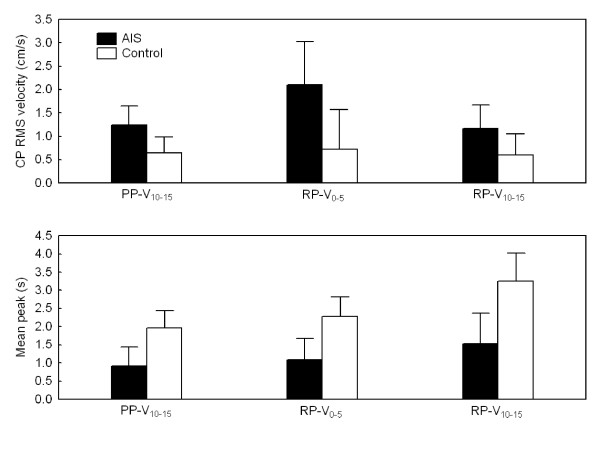
Balance control performance during reintegration of ankle proprioception when vision is available. Upper panel illustrates the interaction Group by Epoch for the CP RMS velocity for the last 5 s epoch of sensory deprivation internal (PP-V10–15 perturbed proprioception/vision) and for the first and last 5 s epoch of the sensory reintegration interval (RP-V0–5 and RP-V10–15 reintegration proprioception/vision). Lower panel shows the interaction Group by Epoch for the time spent within the zone of stability for the same 5 s epochs as the upper panels. On all panels, the error bars correspond to 95% confidence intervals.